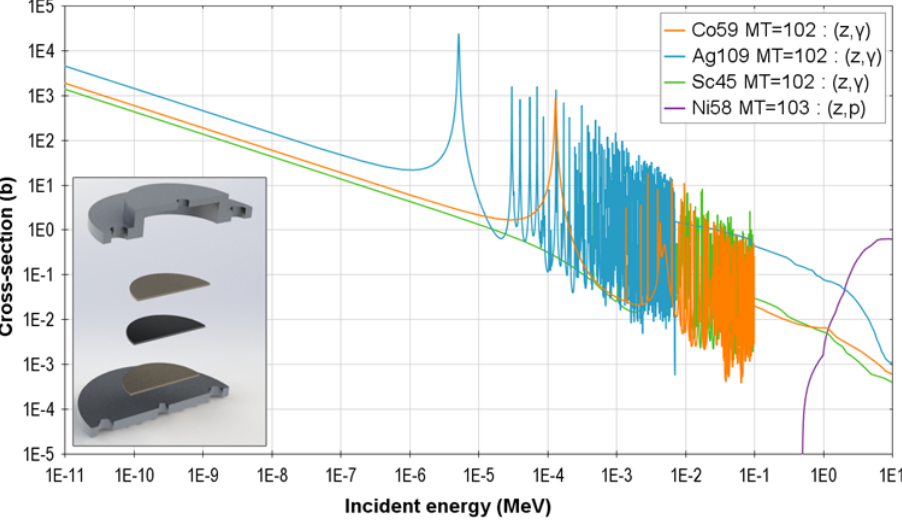
Figure 2. Cross sections of relevant foil activation reactions; bottom left: extruded cut view of a validation sample (foils inside a